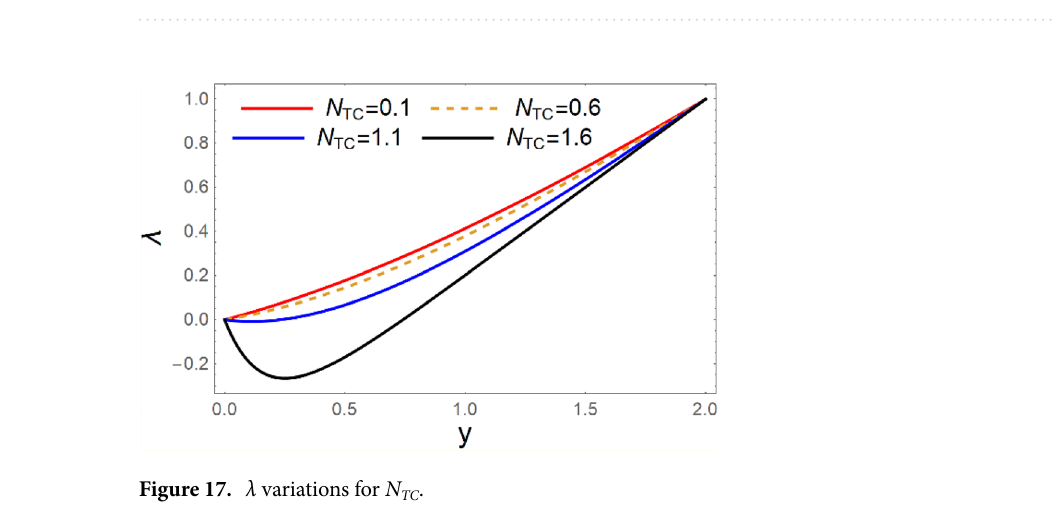
Figure 16. λ variations for N CT .